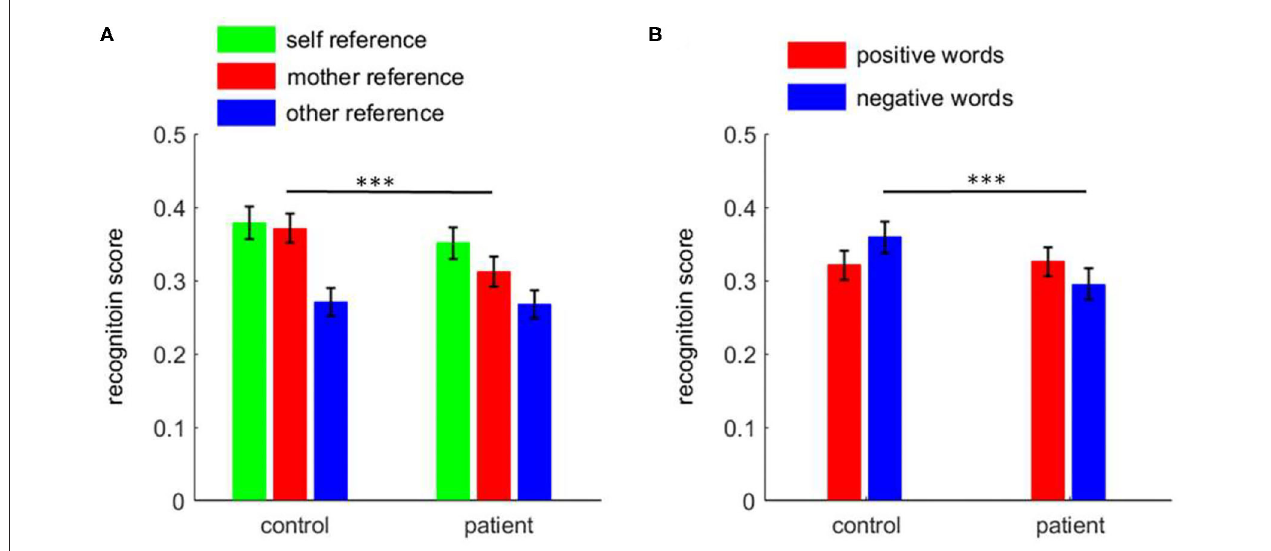
FIGURE 2 | The recognition score among patients with first-episode schizophrenia and healthy control subjects. (A) the task effect; (B) the emotion effect. *** p < 0.001.